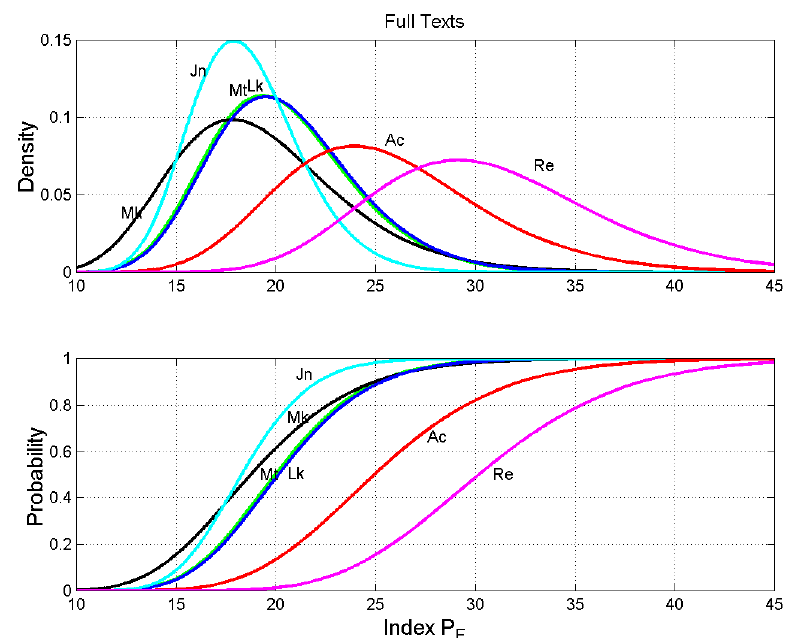
Figure 1. Probability density functions (upper panel) and probability distribution functions (lower panel) of the number of words per sentence 𝑃 𝐹 . Matthew : green line; Mark: black line; Luke : blue line; John : cyan line; Acts : red line; Revelation : magenta line.